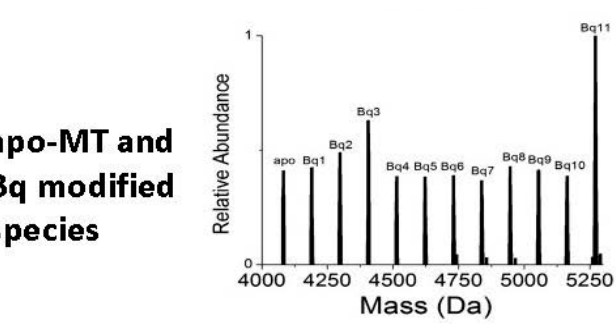
Figure 5. Modification of apo-As 1 and As 3 - α MT solution with p -benzoquinone (Bq). The original spectra after modification is shown at the top. The individual species and their modifications are isolated from the top spectra and are shown below in the left column. Adapted with permission from Irvine et al., 2013 [44].